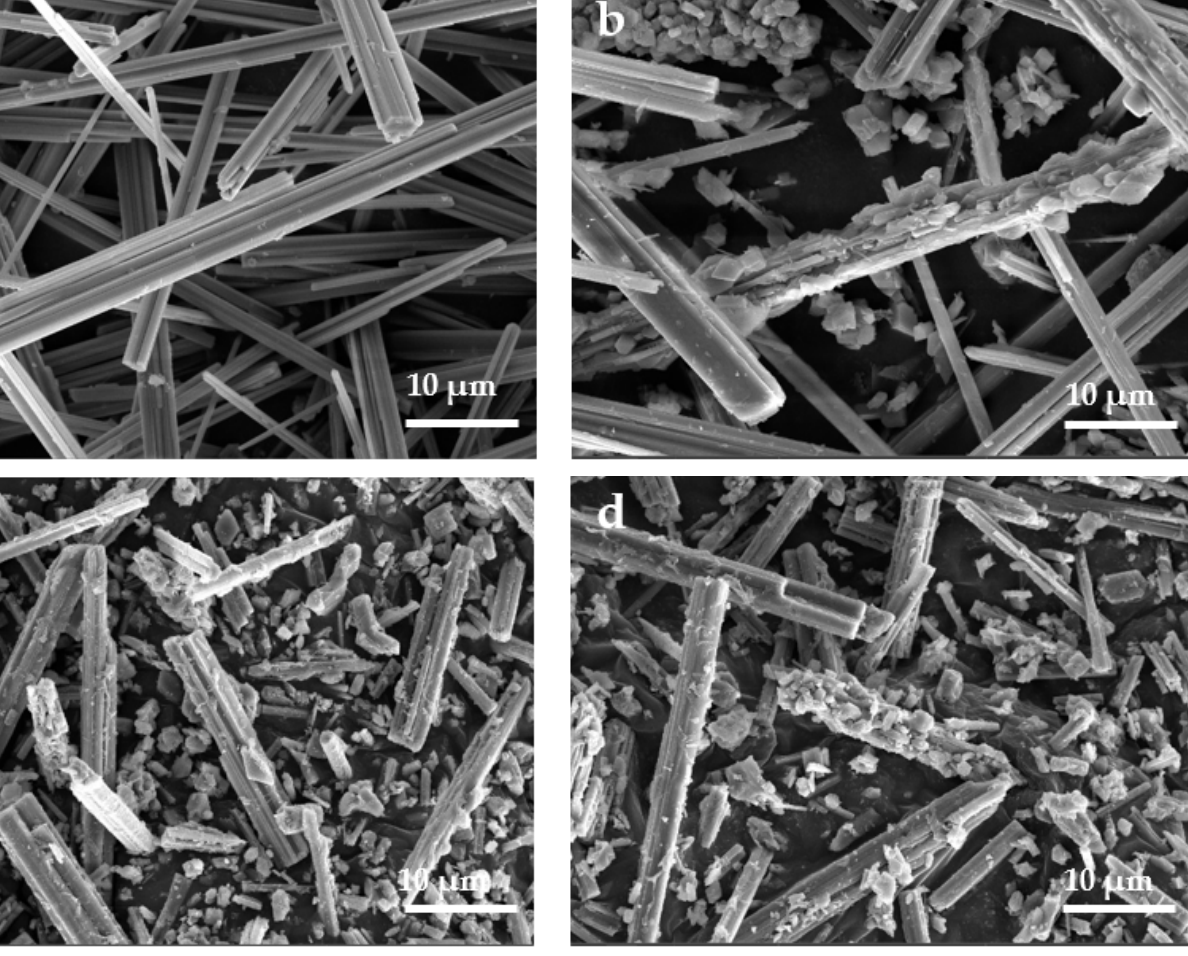
Figure 5. SEM images of ( a ) CSW, ( b ) CSW-OH, ( c ) CSW-OH-KH570, and ( d ) CSW-g-PMMA.